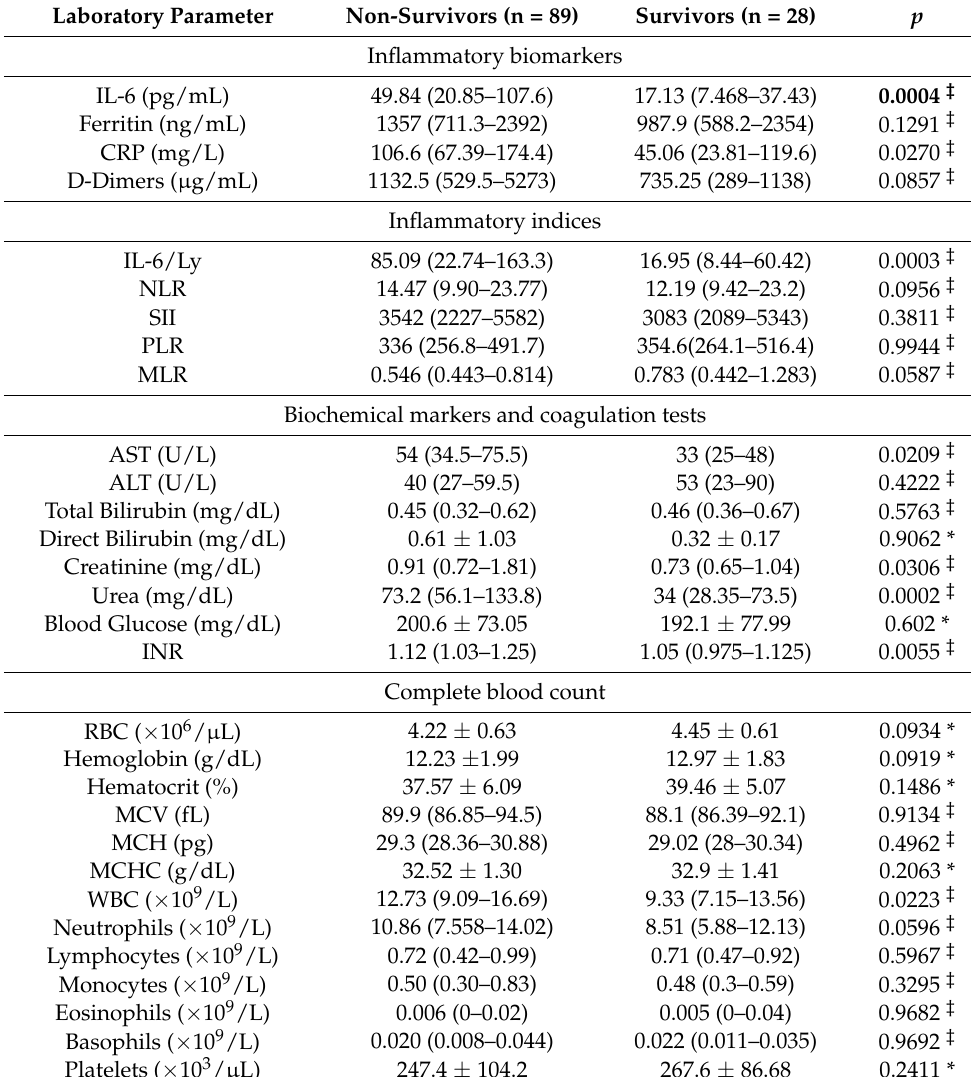
Table 2. Comparison of laboratory characteristics between survivors and